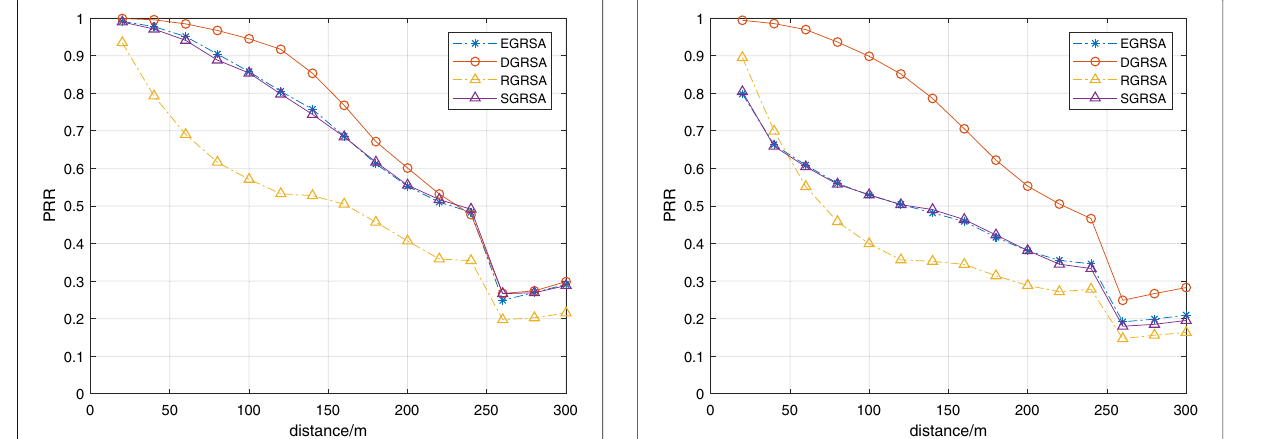
Fig. 18 The PRR of DGRSA when the number of VUEs is 1200 in the jam scene. The packet reception ratio (PRR) curve changes with distance when jam areas are areas 1, 2, 7, and 8 and the number of vehicle user equipments (VUEs) is 1200. Four geo-based algorithms namely random geo-based resource selection algorithm (RGRSA), sensing geo-basedresourceselection algorithm (SGRSA), the proposed enhanced geo-based resource selection algorithm (EGRSA), and the proposed dynamic geo-based resource selection algorithm (DGRSA) are compared in this figure. The line with red circles represents the proposed DGRSA. The line with blue stars represents the proposed EGRSA. The line with purple triangles represents the SGRSA. The line with yellow triangles represents